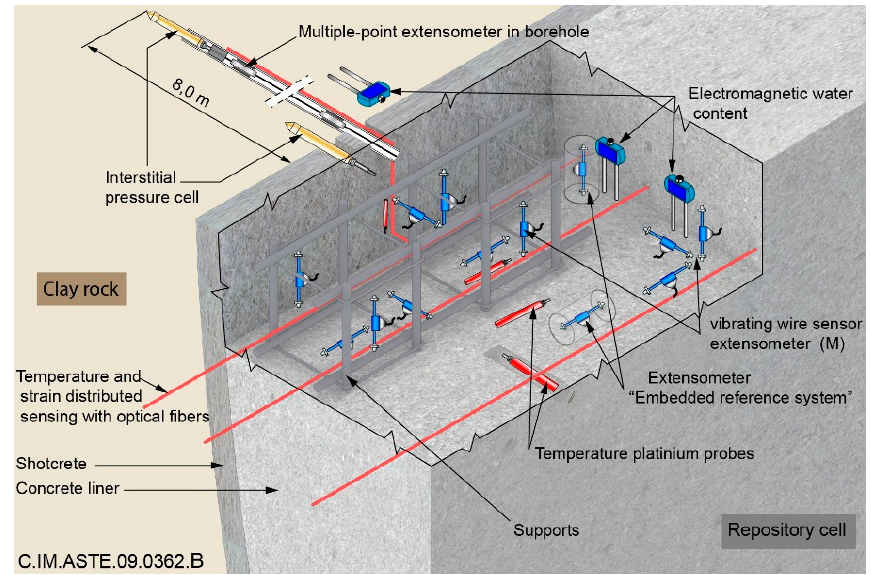
Figure 1. Envisioned monitoring in a nuclear waste repository.